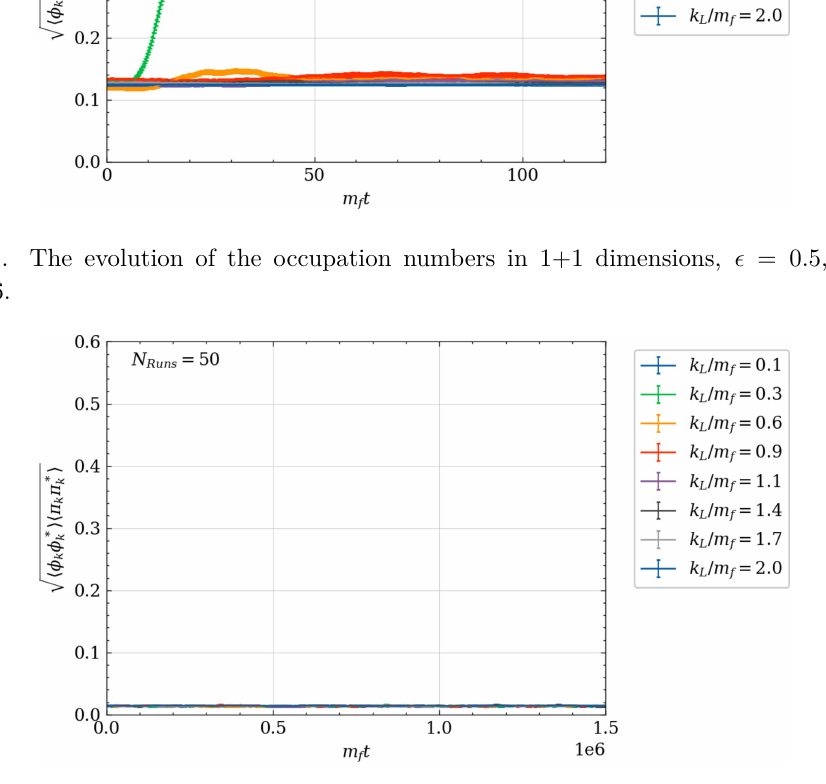
Figure 13 . The evolution of the occupation numbers in 1+1 dimensions, (cid:15) = 0 . 17 , φ 0 = 1 . 5 , am f = 0 . 06